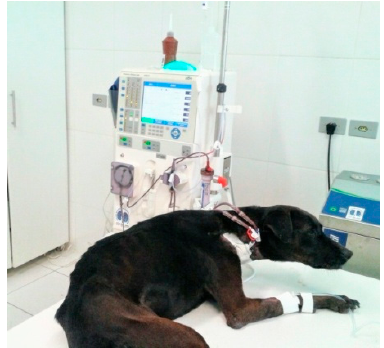
Figure 1. Dog with International Renal Interest Society (IRIS) chronic kidney disease (CKD) Stage 4 during intermittent haemodialysis (IHD) session.